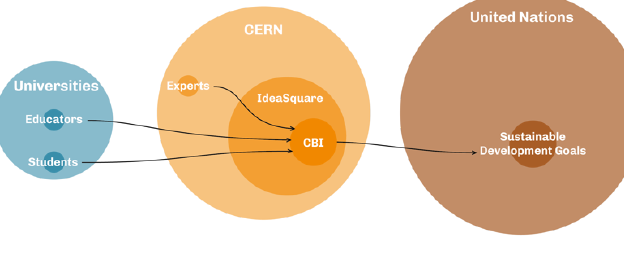
Fig. 1. CBI stakeholders.